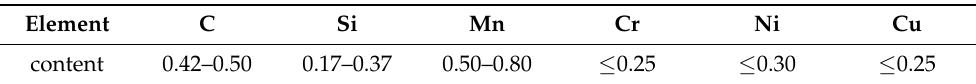
Table 1. The 45 steel small amount of chemical element composition (wt. %).